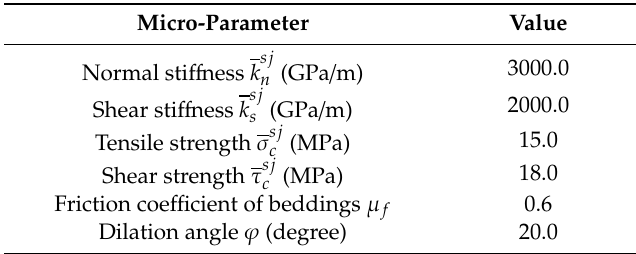
Table 2. Micro-constitutive parameters calibrated for